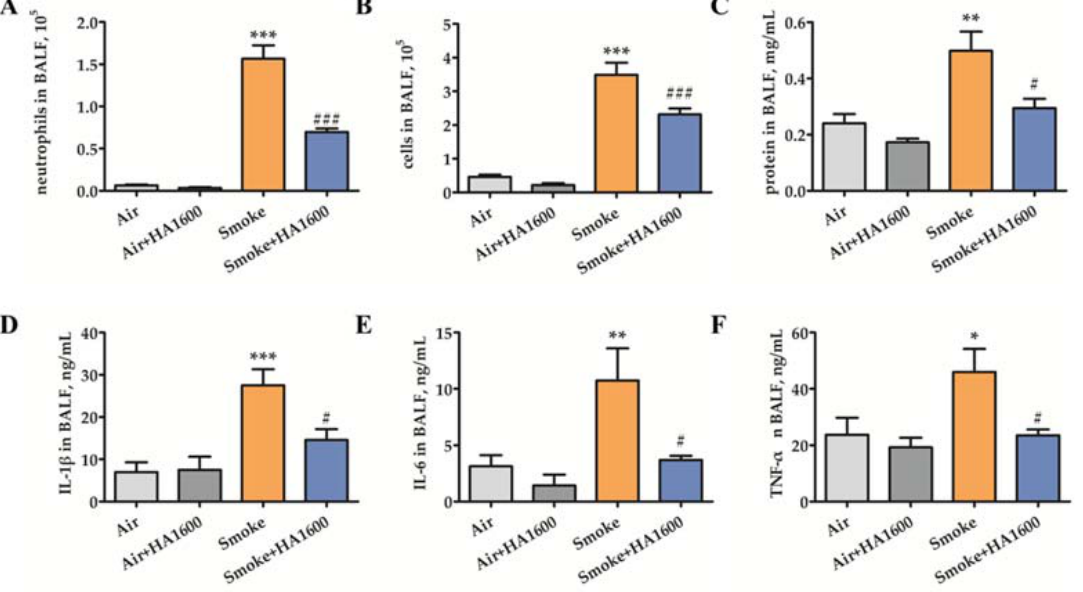
Figure 2. Intratracheal nebulization with HA1600 inhibited pulmonary inflammation after smoke exposure. ( A ) Numbers of neutrophils in bronchoalveolar lavage fluid (BALF) were determined by Wright-Giemsa staining. ( B ) Total cells in BALF were counted. ( C ) Total protein level in BALF was measured by Bicinchoninic Acid (BCA) Protein Assay Kit. The level of inflammatory cytokines in BALF, including ( D ) interleukin (IL)-1 β , ( E ) IL-6, and ( F ) tumor necrosis factor (TNF)- α , was detected by enzyme-linked immunosorbent assay (ELISA) kit. Data are represented as means ± SEM ( n = 6). *** p < 0.001, ** p < 0.01, and * p < 0.05 vs. Air group (the control group); ### p < 0.001, # p < 0.05 vs. Smoke group.